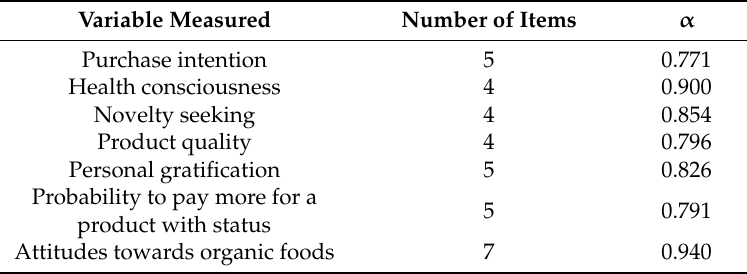
Table 1. Items and α coefficients of the constructs.